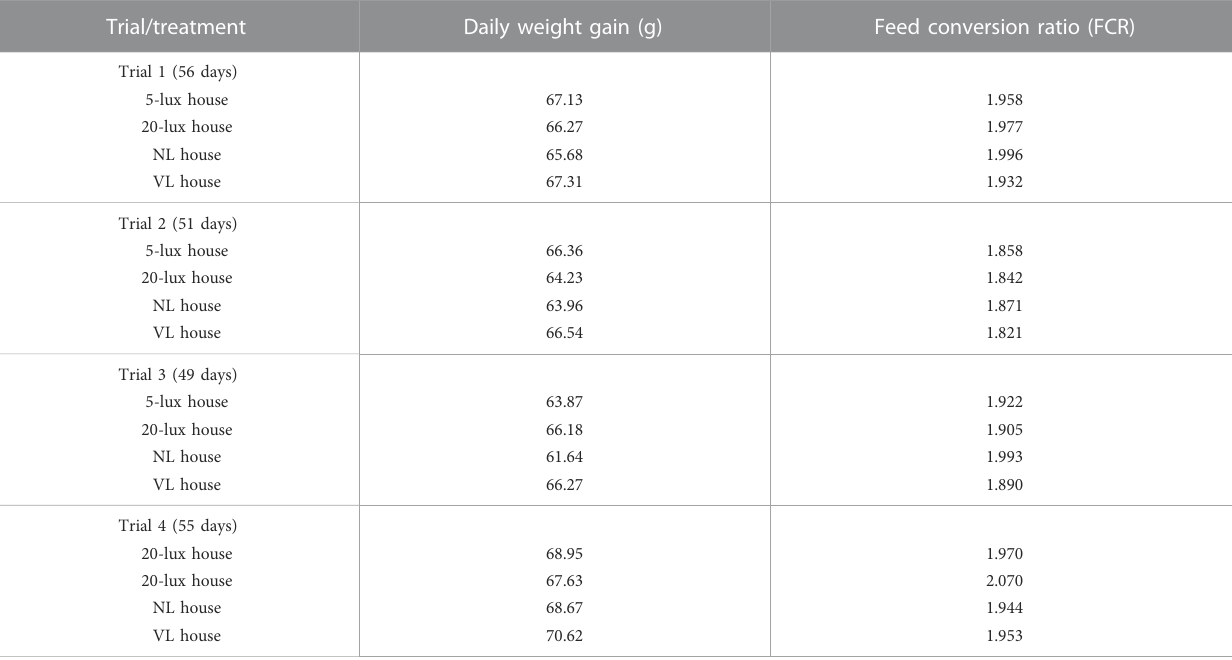
TABLE 2 Effects of different light programs on the production performance of commercial broilers.